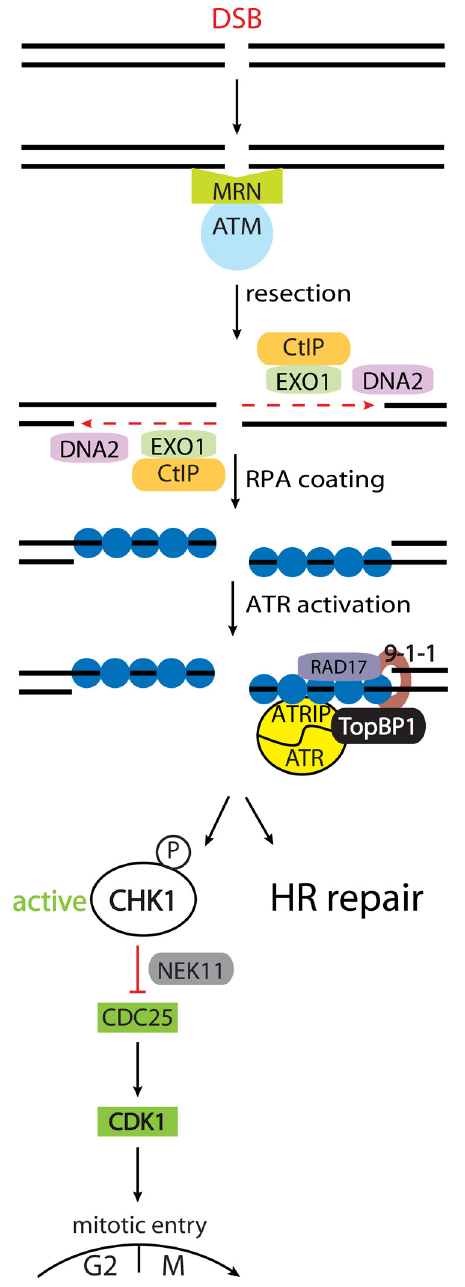
Figure 1. Activation of the checkpoint regulator (CHK1) in response to DNA Double Strand Breaks (DSBs). The MRN complex detects DSBs and recruits